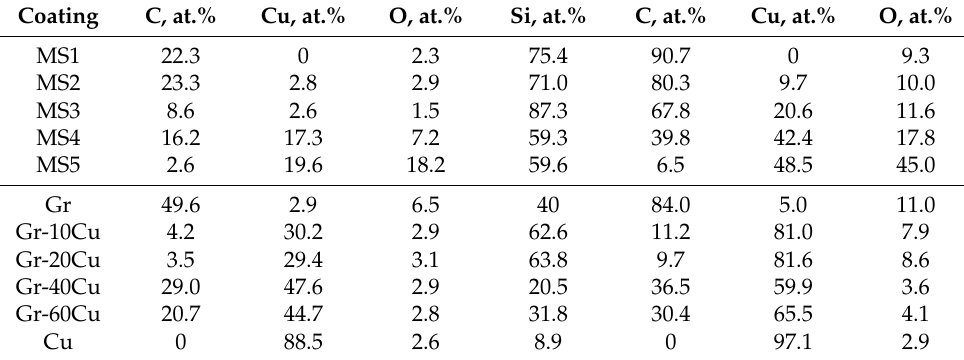
Table 1. Elemental composition of films formed using magnetron sputtering and plasma spraying (as deposited and recalculated with the elimination of Si). Coating C, at.% Cu, at.% O, at.% Si, at.% C, at.% Cu,